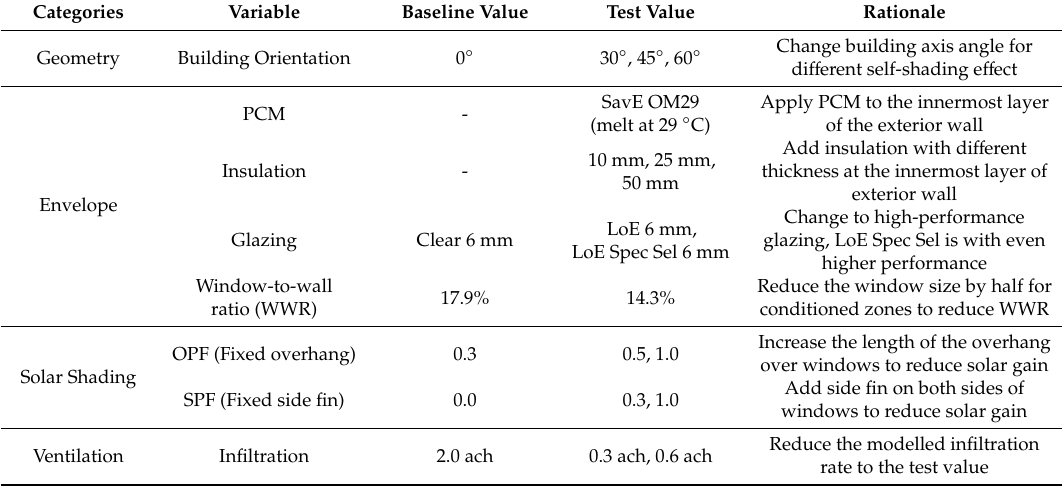
Table 4. Passive cooling techniques simulation inputs in EnergyPlus